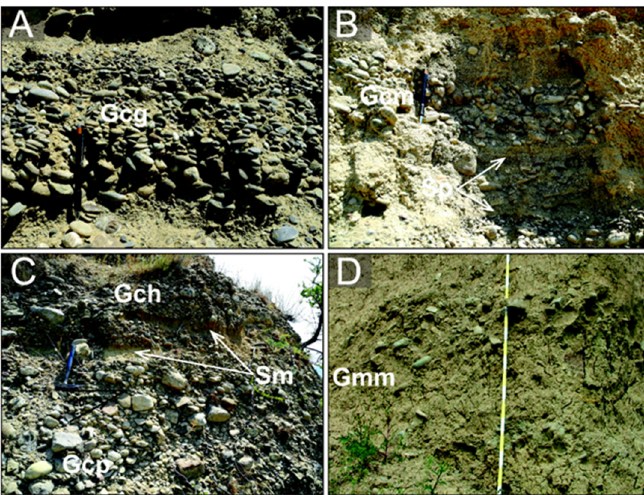
Figure 4. Photos showing the main gravelly facies ( A , B , C , and D ), with subordinate sandy facies (A, and C), recognized in the Pescogrosso fluvial catchment. For facies code and interpretation see Table